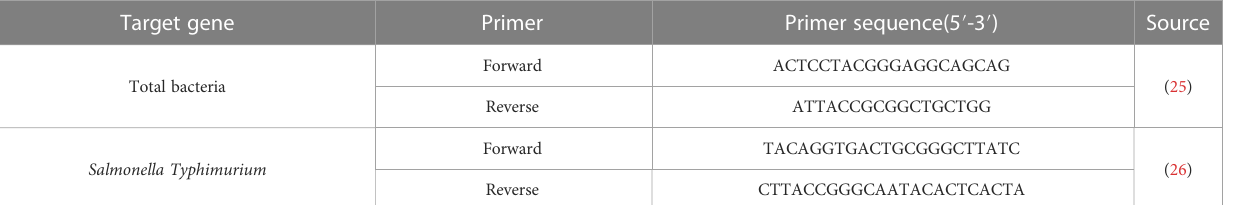
TABLE 1 Primers sequence table.